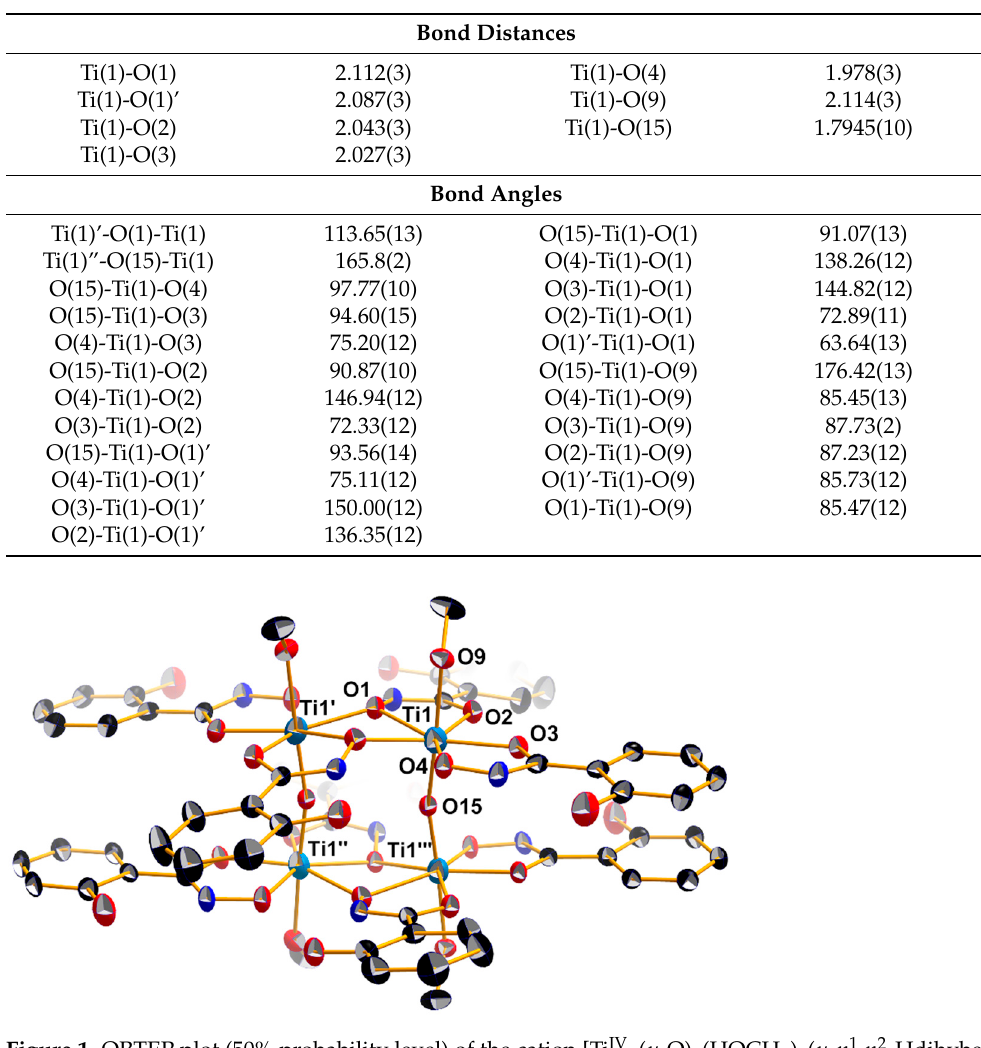
Figure 1. ORTEP plot (50% probability level) of the cation [Ti IV4 ( μ -O) 2 (HOCH 3 ) 4 ( μ - η 1 , η 2 -Hdihybe- O , O ′ ) 4 ( η 1 , η 1 -Hdihybe- O , O ′ ) 4 ] 4+ of 1 with a partial labeling scheme. Hydrogen atoms are omitted for clarity.